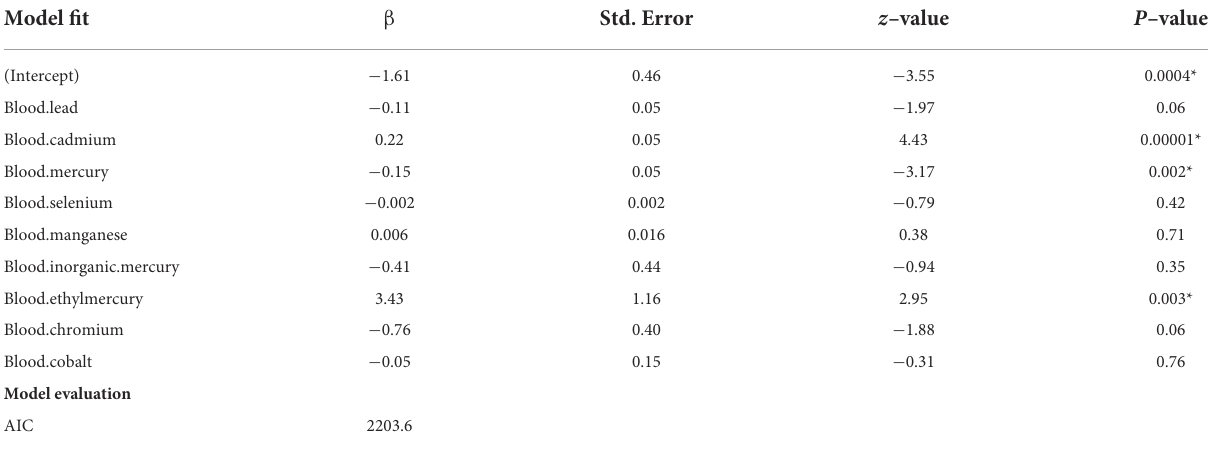
TABLE 3 Poisson regression model of 9 metal elements.